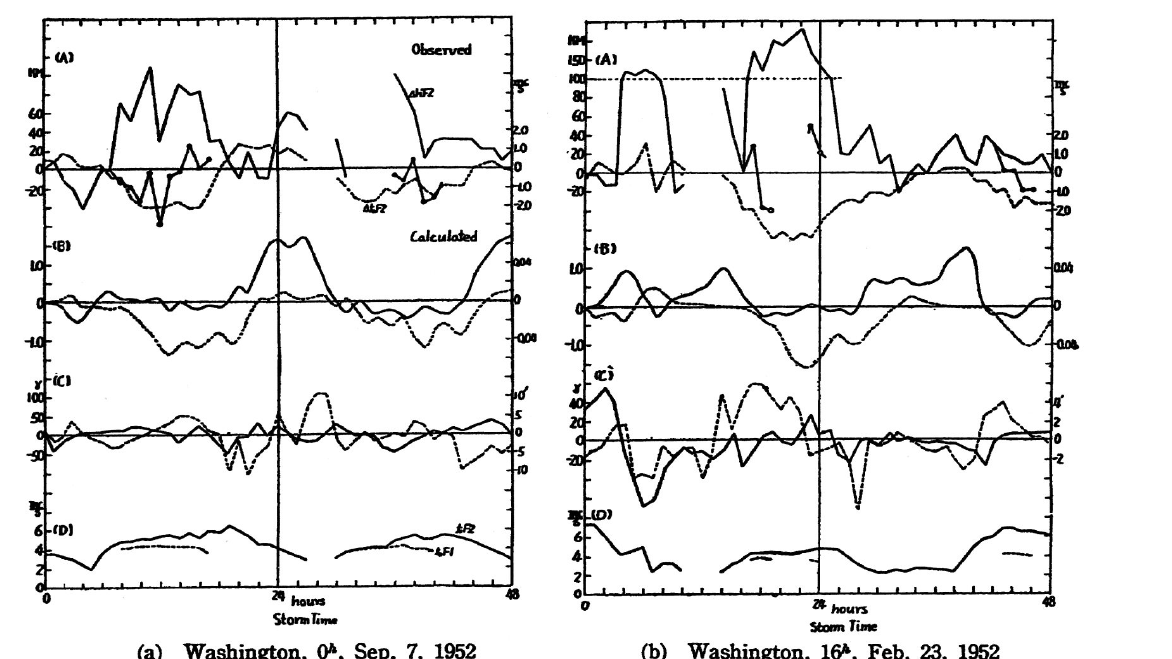
Figure 6. Comparison between (A) the observed and (B) the calculated variations of the F2 layer at Washington during ionospheric distur- bances. The bottom panels show observations of (C) the magnetic field and (D) the ionosphere (Sato, 1957).